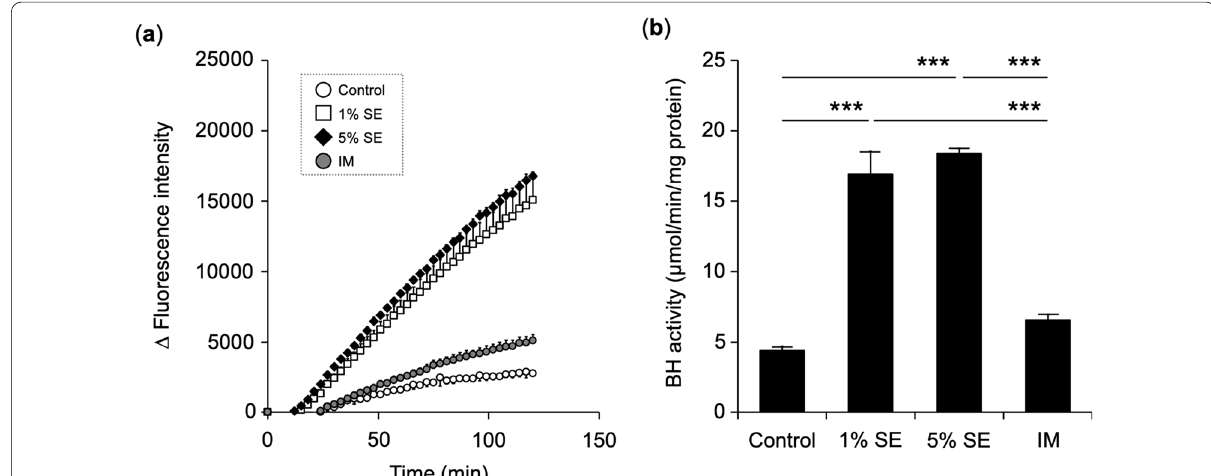
Fig. 4 Effects of BH activity in three-dimensional cultured human epidermis. Three-dimensional cultured human epidermis was treated with SE or IM for 8 days. Samples were assayed for BH activity toward citrulline-4-methylcoumaryl-7-amide (Cit-AMC). a Amount of change in fluorescence intensity up to 120 min. b BH activity. Data are expressed as mean S.D. of three independent experiments. *** p < 0.001. Statistical significance was ± evaluated using Tukey’s post hoc multiple comparison